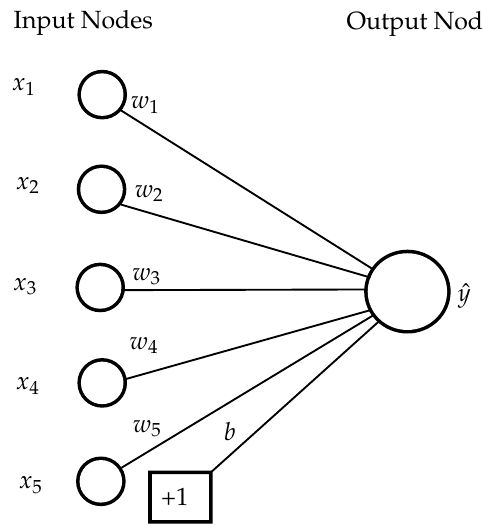
Figure 3. Basic architecture of a perceptron based on